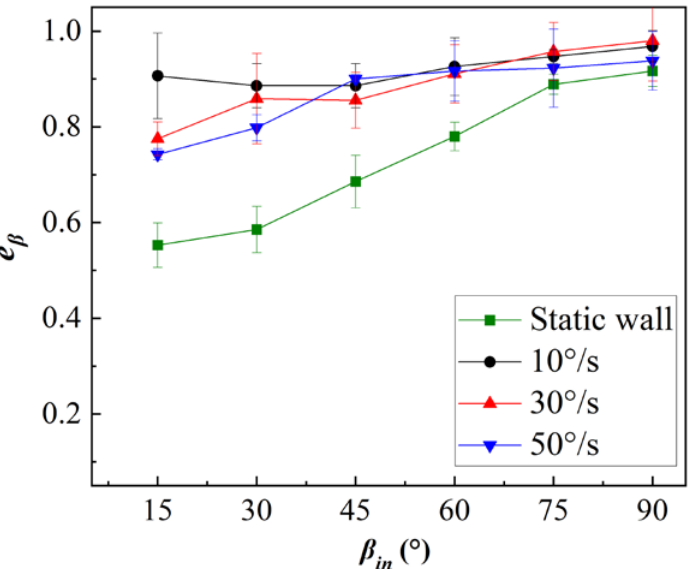
Figure 7. Influences of different rotational speeds on the particle angle coefficient of restitution.